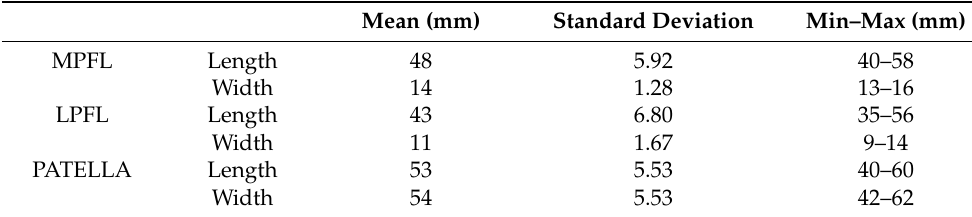
(MPFL: Medial patellofemoral ligament; LPFL: Lateral patellofemoral ligament; Min: minimum; Max: